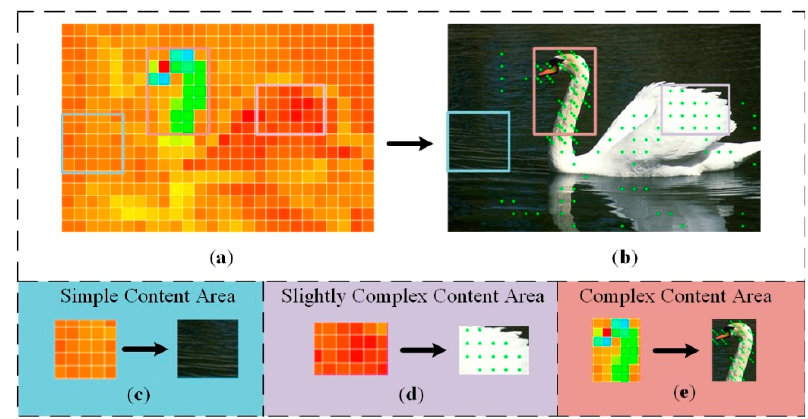
Figure 5. Region division of different content complexity. ( a ) Three regions with different complexity are represented by three color boxes, respectively; ( b ) Different complexity of seed initialization methods are different; ( c ) Simple content of the seed initialization method; ( d ) Slightly complex region of the seed initialization method; ( e ) Complex content of the seed initialization method.